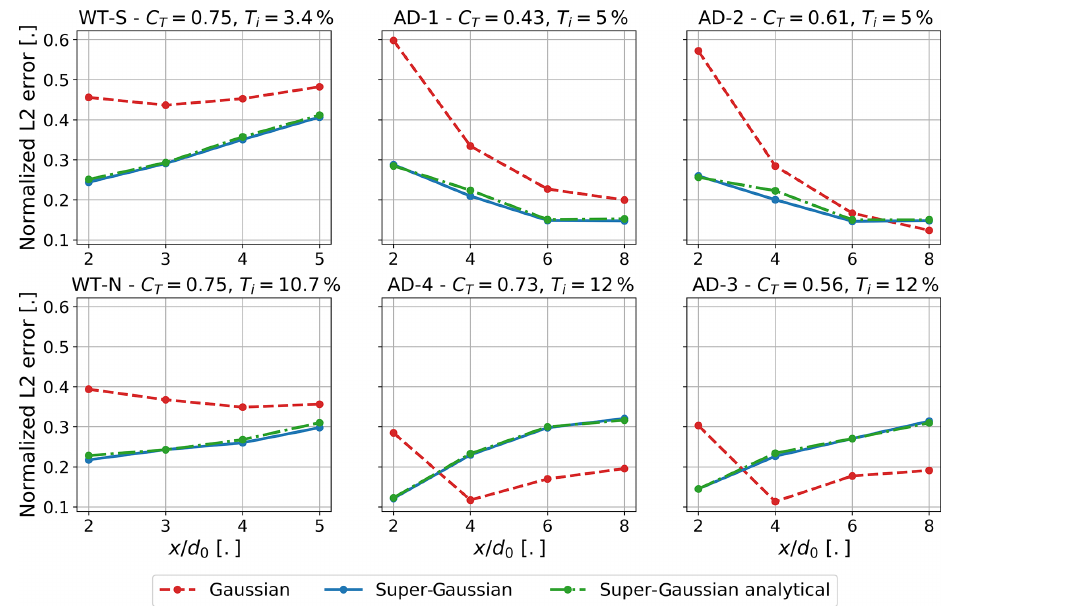
Figure 6. Normalized L 2 error between the wake models and measured velocity deficit for the six considered cases. Lower-inflow-turbulence cases on the top line, higher-inflow-turbulence cases on the bottom